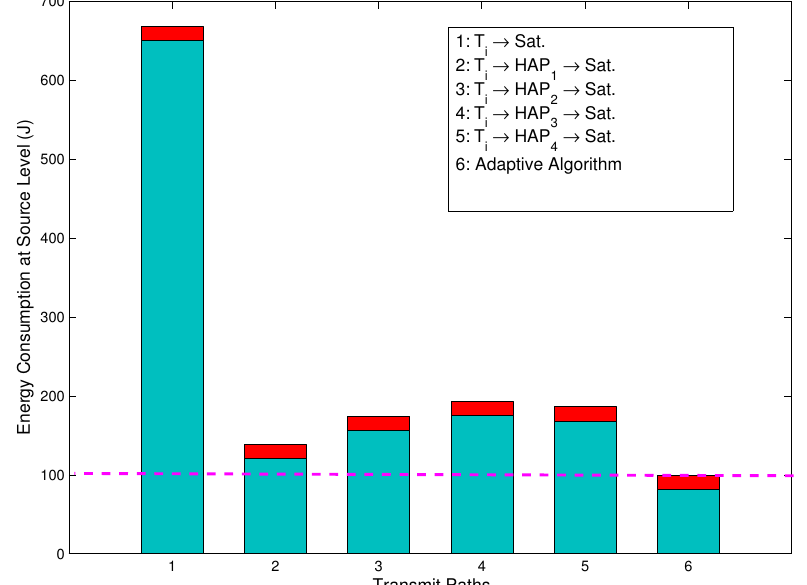
Figure 3. Energy consumption for the direct path, relay paths and adaptive path selection at the source level.